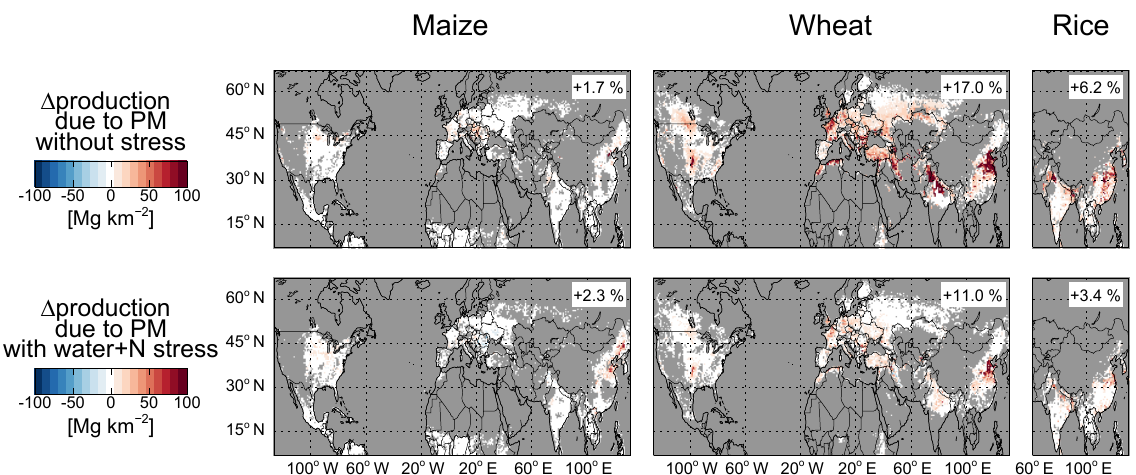
Figure 3. Change in pDSSAT crop production due to PM with max (cid:49) RUE = 100% with no stress (top row panels) and water and nitrogen (N) stresses (bottom row panels) applied. For growing season ending in 2010 for maize (left column panels), wheat (middle column panels), and rice (right column panels). Filtered for GAEZ base crop production greater than 0.01Mgkm − 2 . Global relative production change shown in upper right of each